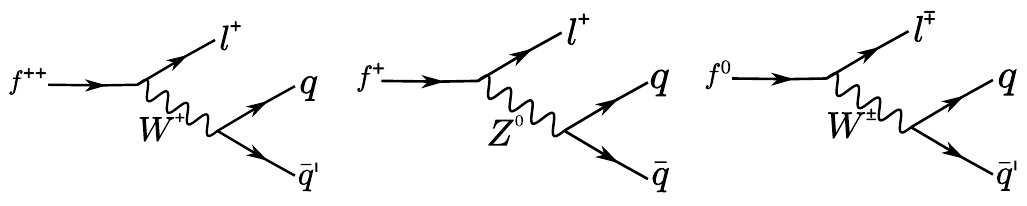
Figure 13 . Example Feynman diagrams for the decays of exotic fermions appearing in our high- dimensional neutrino mass